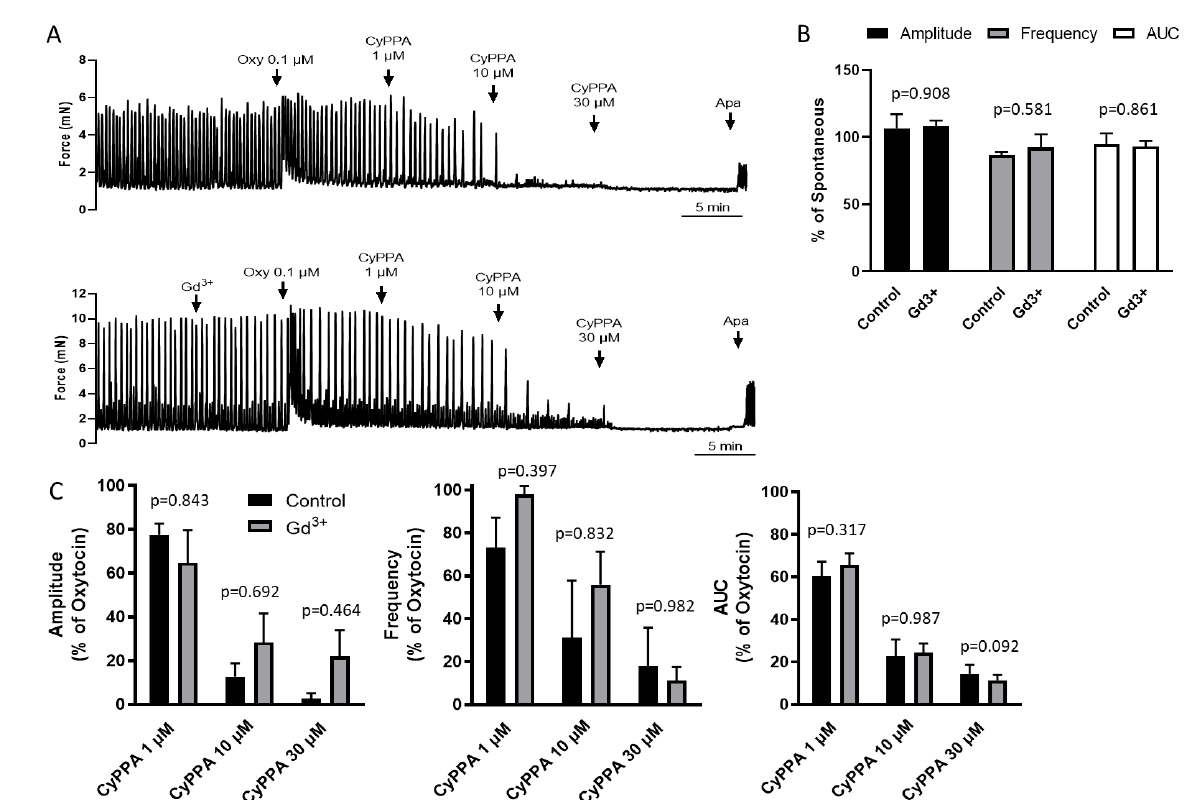
Figure 3. Effect of nonselective cation channel blockade on CyPPA suppression of phasic uterine contractions. ( A ) Represen- tative myography recording of uterine strips pretreated with Gd 3+ (30 µ M) before exposure to oxytocin and subsequent increasing concentrations of CyPPA. Finally, strips were exposed to the K Ca 2 inhibitor apamin (0.6 µ M). ( B ) Summary of Gd 3+ effects on contraction amplitude, frequency and AUC. ( C ) Summary of CyPPA effects on contraction amplitude, frequency and AUC under the conditions tested; ( n = 6).